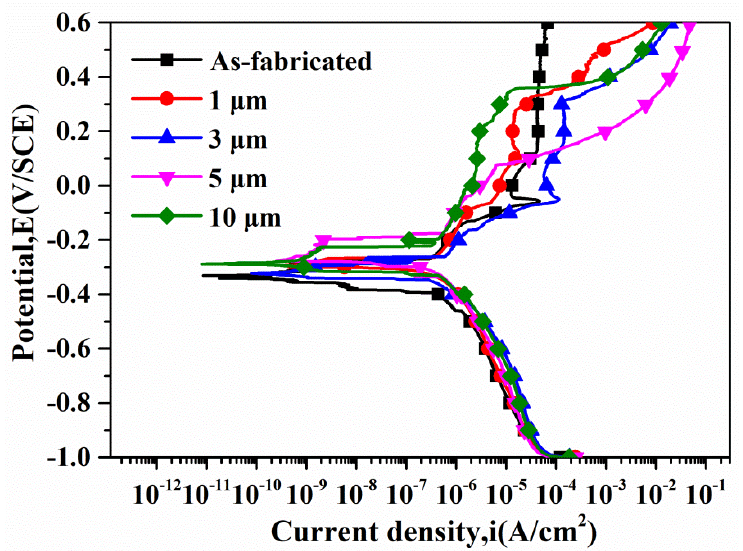
Figure 8. Polarization curves in 3.5 wt % NaCl solution under different process parameters.